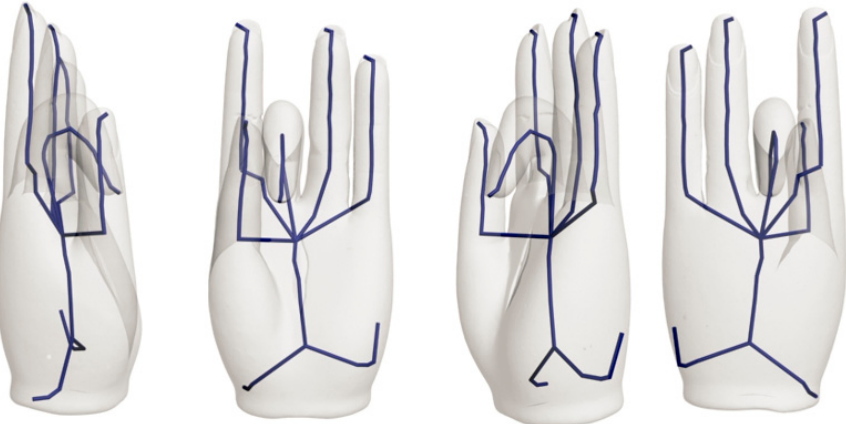
Figure 10. Comparison of skeleton nodes before and after fine-tuning.